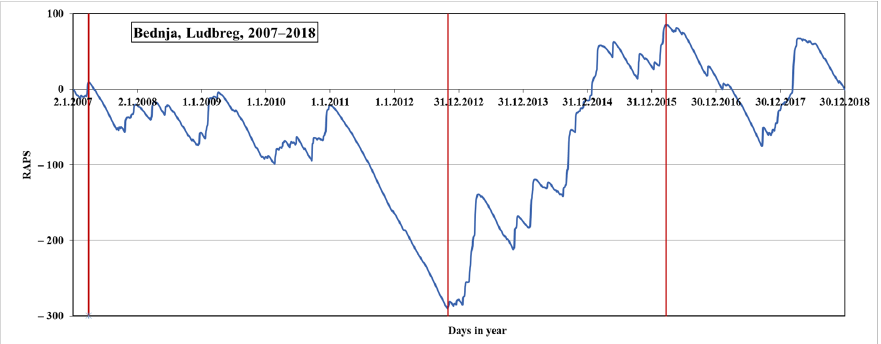
Figure 16. RAPS value on flow data from Ludbreg measurement station.